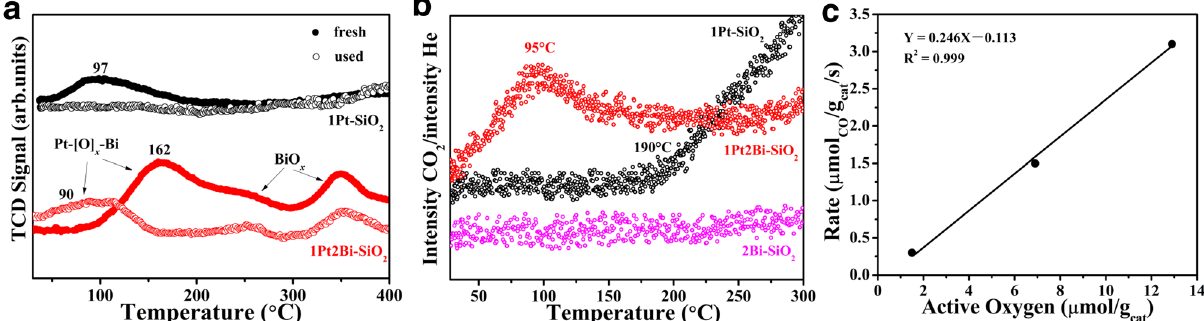
Fig. 6 The reducible property and active oxygen for Pt/PtBi-SiO 2 . a H 2 − TPR pro fi les of fresh Pt/PtBi – SiO 2 catalysts and used catalysts after CO oxidation without exposure to air; b in-situ CO − TPR of used Pt/PtBi-SiO 2 samples after CO oxidation without exposure to air; c linear equation for active oxygen vs reaction rate for used Pt/PtBi – SiO 2